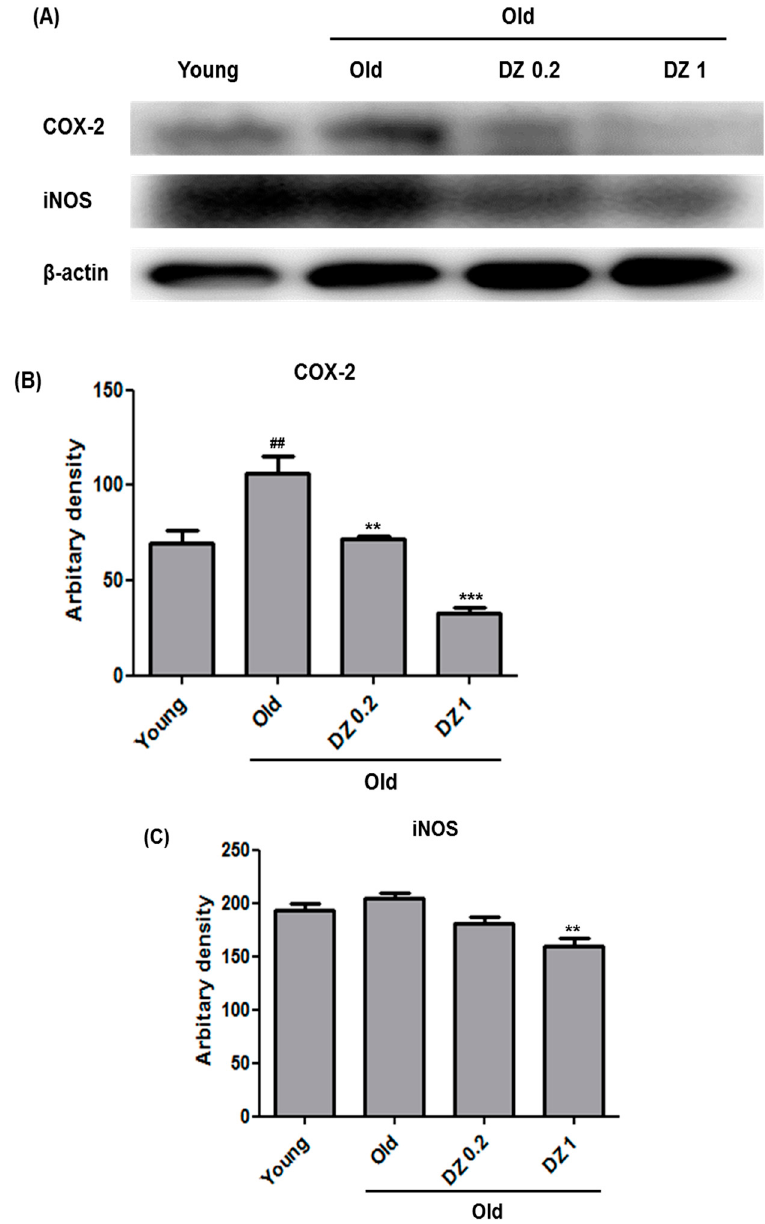
Figure 6. Inhibition of COX-2 and iNOS expression in rat aorta by Dendranthema zawadskii (DZ) extract. ( A ) Western blot analysis was performed to detect COX-2 and iNOS protein level in cytosol extract (40 μ g protein), aorta tissue from each group. Young, 5-month-old rats; Old, 15-month-old rats; DZ 0.2, 15-month-old rats treated with DZ extract (0.2 mg/kg/day) for 1 week; DZ 1, 15- month-old rats treated with DZ extract (1 mg/kg/day) for 1 week. ( B ) Density analysis of COX-2. Statistical significance: ## < 0.01 compared to young, ** < 0.01 compared to old, *** < 0.001 compared to old, respectively. ( C ) Density analysis of iNOS. Statistical significance: ** < 0.01 compared to old, respectively.